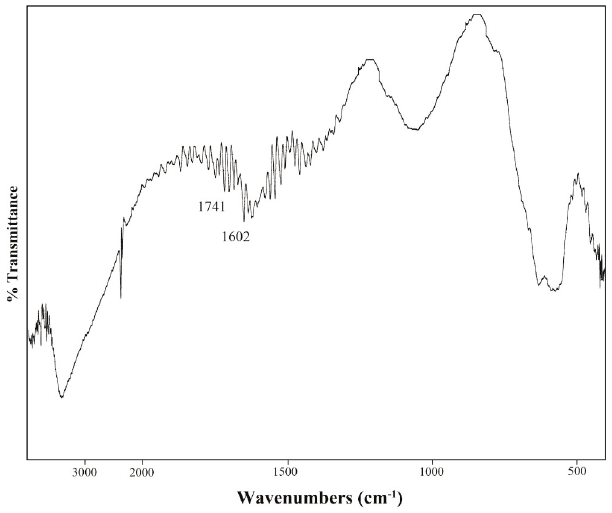
Fig. 1 - IR spectrum of carboxymethylated chitosan. This spec- trum shows that the carboxylmethyl groups (-CH3COOH; 1741 cm -1 ; stretching vibration feature of C=O groups) resulted from monochlroacetic acid salt are linked to O atom in -OH group, and -NH 2 exists on car- boxymethylated